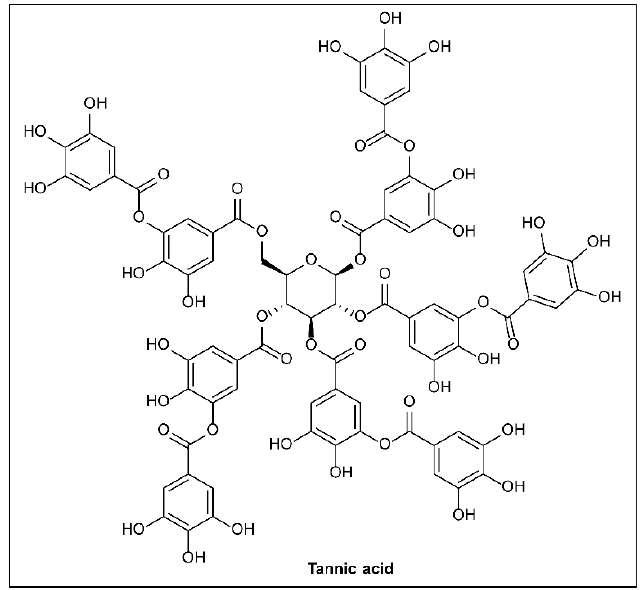
Figure 15. Structures of tannic acid.